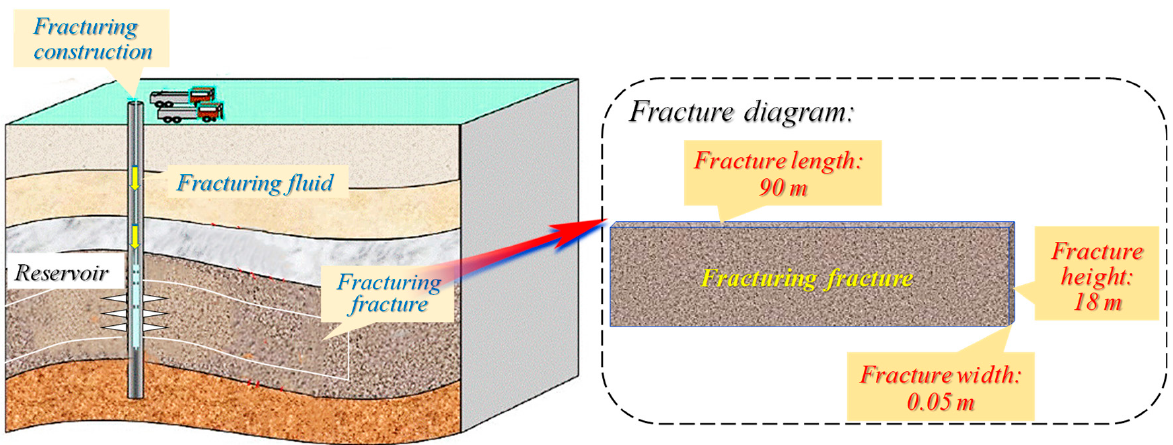
Figure 3. Fracturing construction and fracture diagrams. Table 2. Basic parameters of shale gas